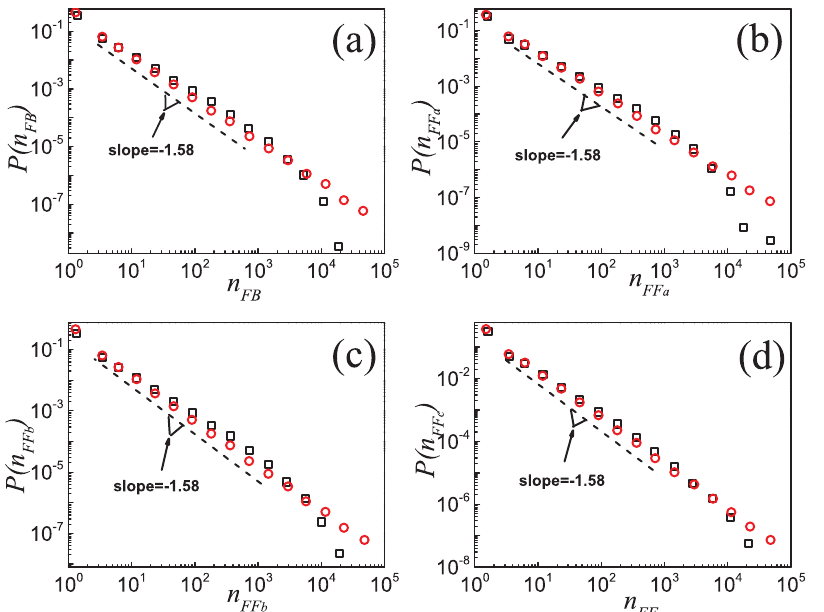
Figure 6. Distributions of four basic closed triples in the Epinions social network and the model. Distributions of closed triples corresponding to (a) FB , (b) FF a , (c) FF b , and (d) FF c loops in the Epinions social network (black squares) and in the simulated network based on the model (red circles). Analytic treatment (see Eqs. (30) and (31)) suggests a scaling behavior with an exponent { 1 : 58 , as shown by the dash lines. Data points are averages over the logarithmic bins of the n FB , n FFa , n FFb and n FFc , respectively.